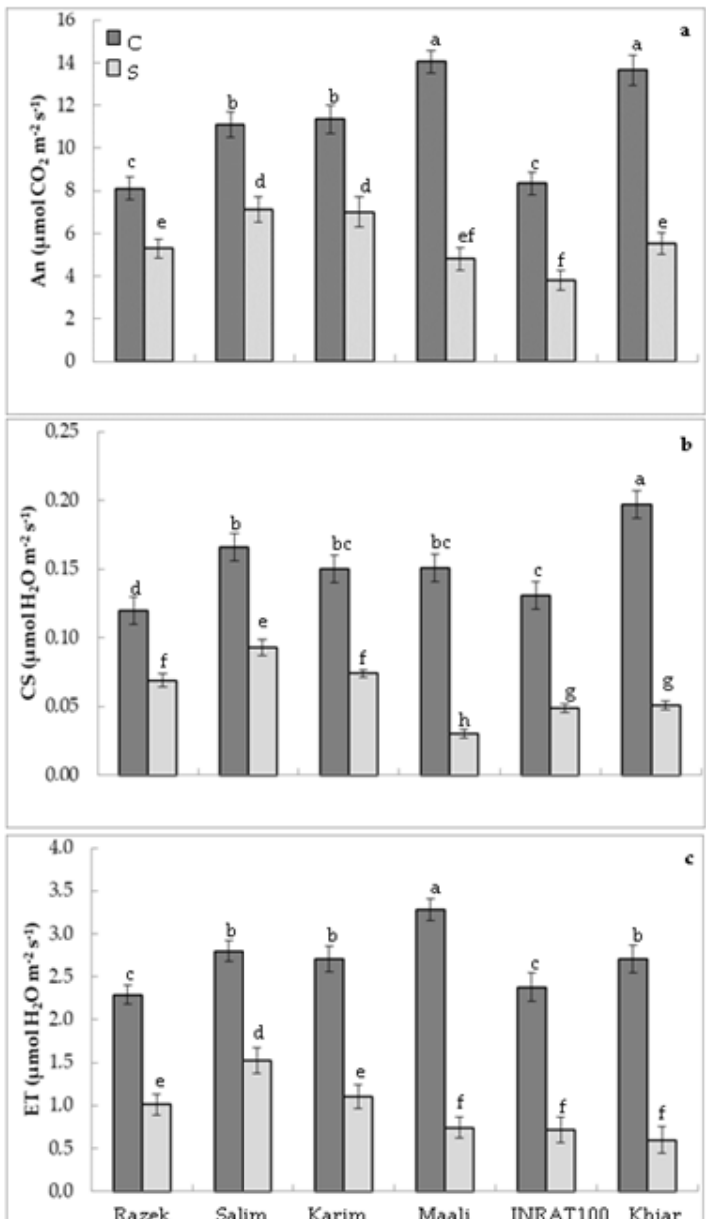
Figure 1. ( a ) Net photosynthetic assimilation (An), ( b ) stomatal conductance (SC), and ( c ) evapotranspiration (ET) in durum wheat ( Triticum durum Desf.) plants subjected (S, stressed) or not (C, control) to drought stress. According to Fisher’s least significant difference, within columns, means with the same letter are not significantly different at α = 0.05. Standard errors of means of 30 rep- licates.